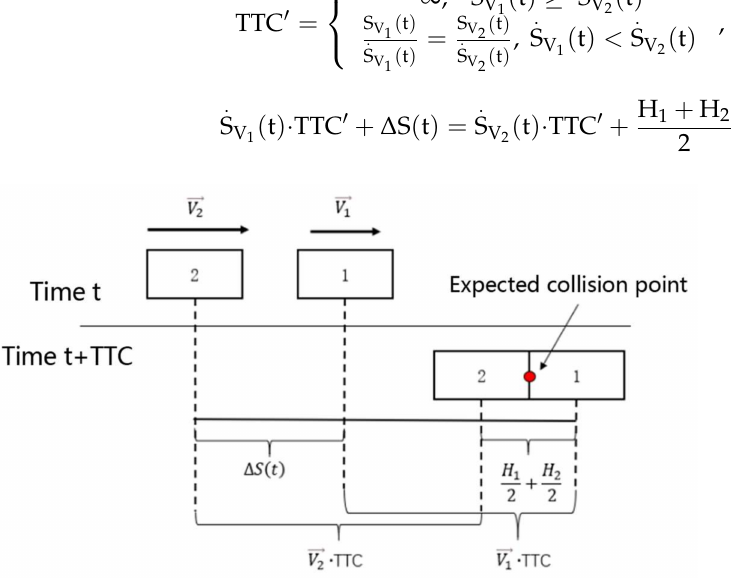
Figure 5. Tailgating conflict considering vehicle